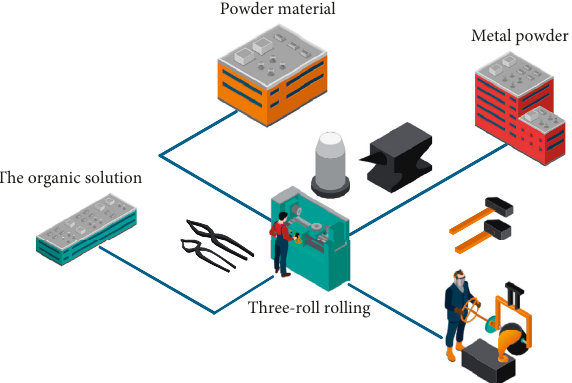
Figure 1: Computer-aided